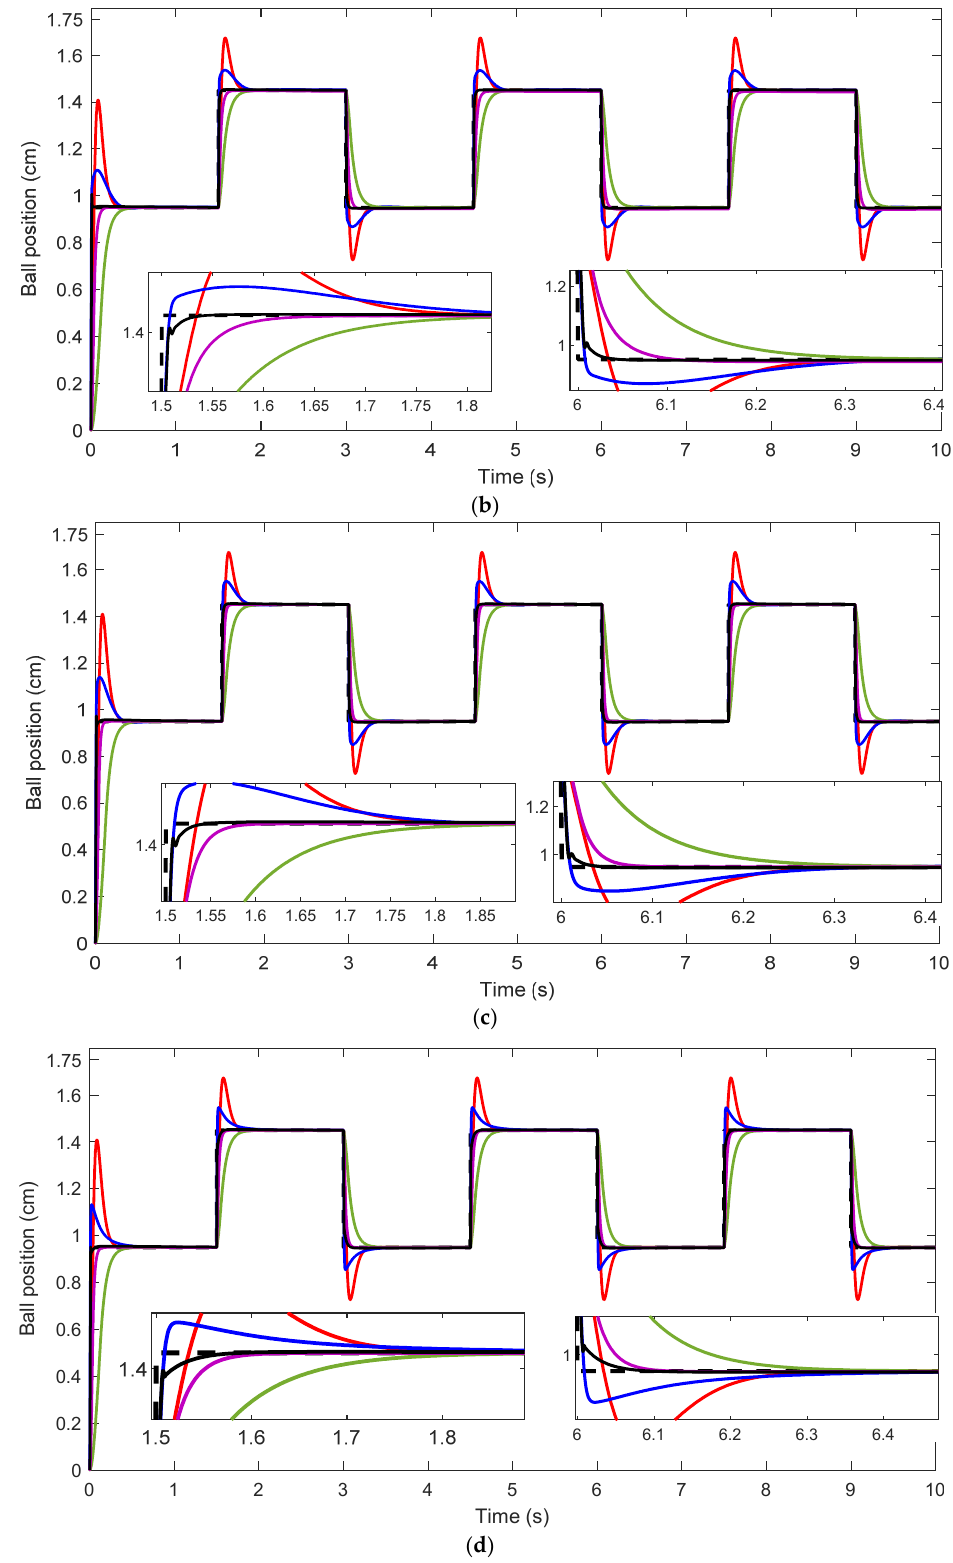
Figure 12. Comparison of Maglev response with different controllers based on J IAE ( a ), J ISE ( b ), J ITAE ( c ), and J ITSE ( d